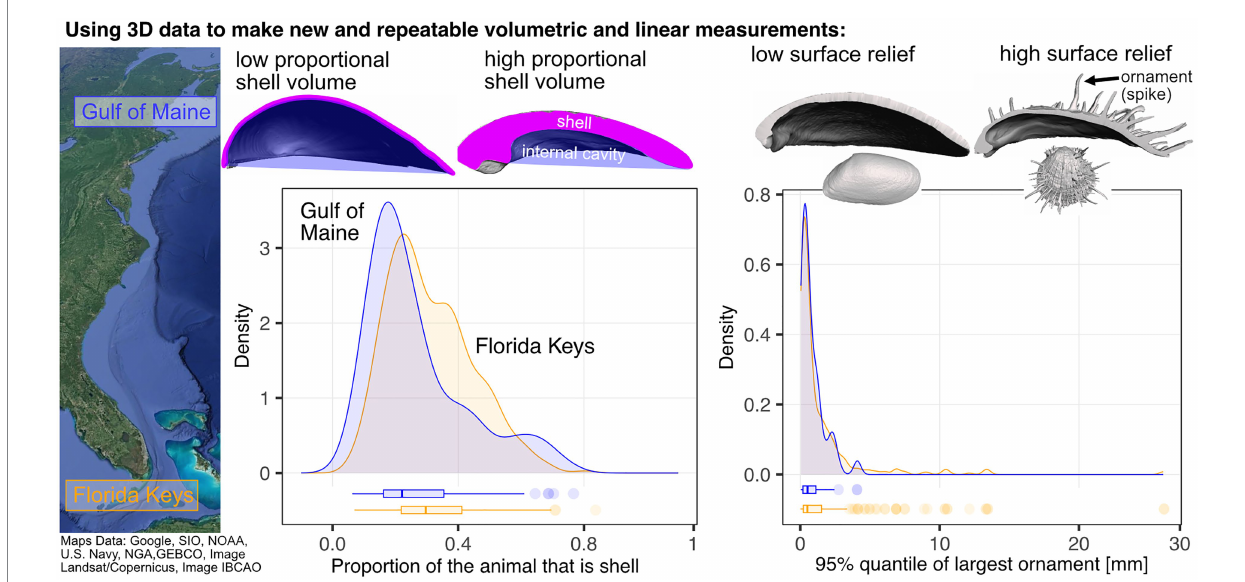
FIGURE 6 Using 3D data to identify latitudinal gradients in shell morphology along the east coast of North America. The proportion of the animal that is shell remains similar between the subtropical Florida Keys and temperate Gulf of Maine, but taxa with the most pronounced ornamentation do not reach the Gulf of Maine (adapted from Collins et al.,